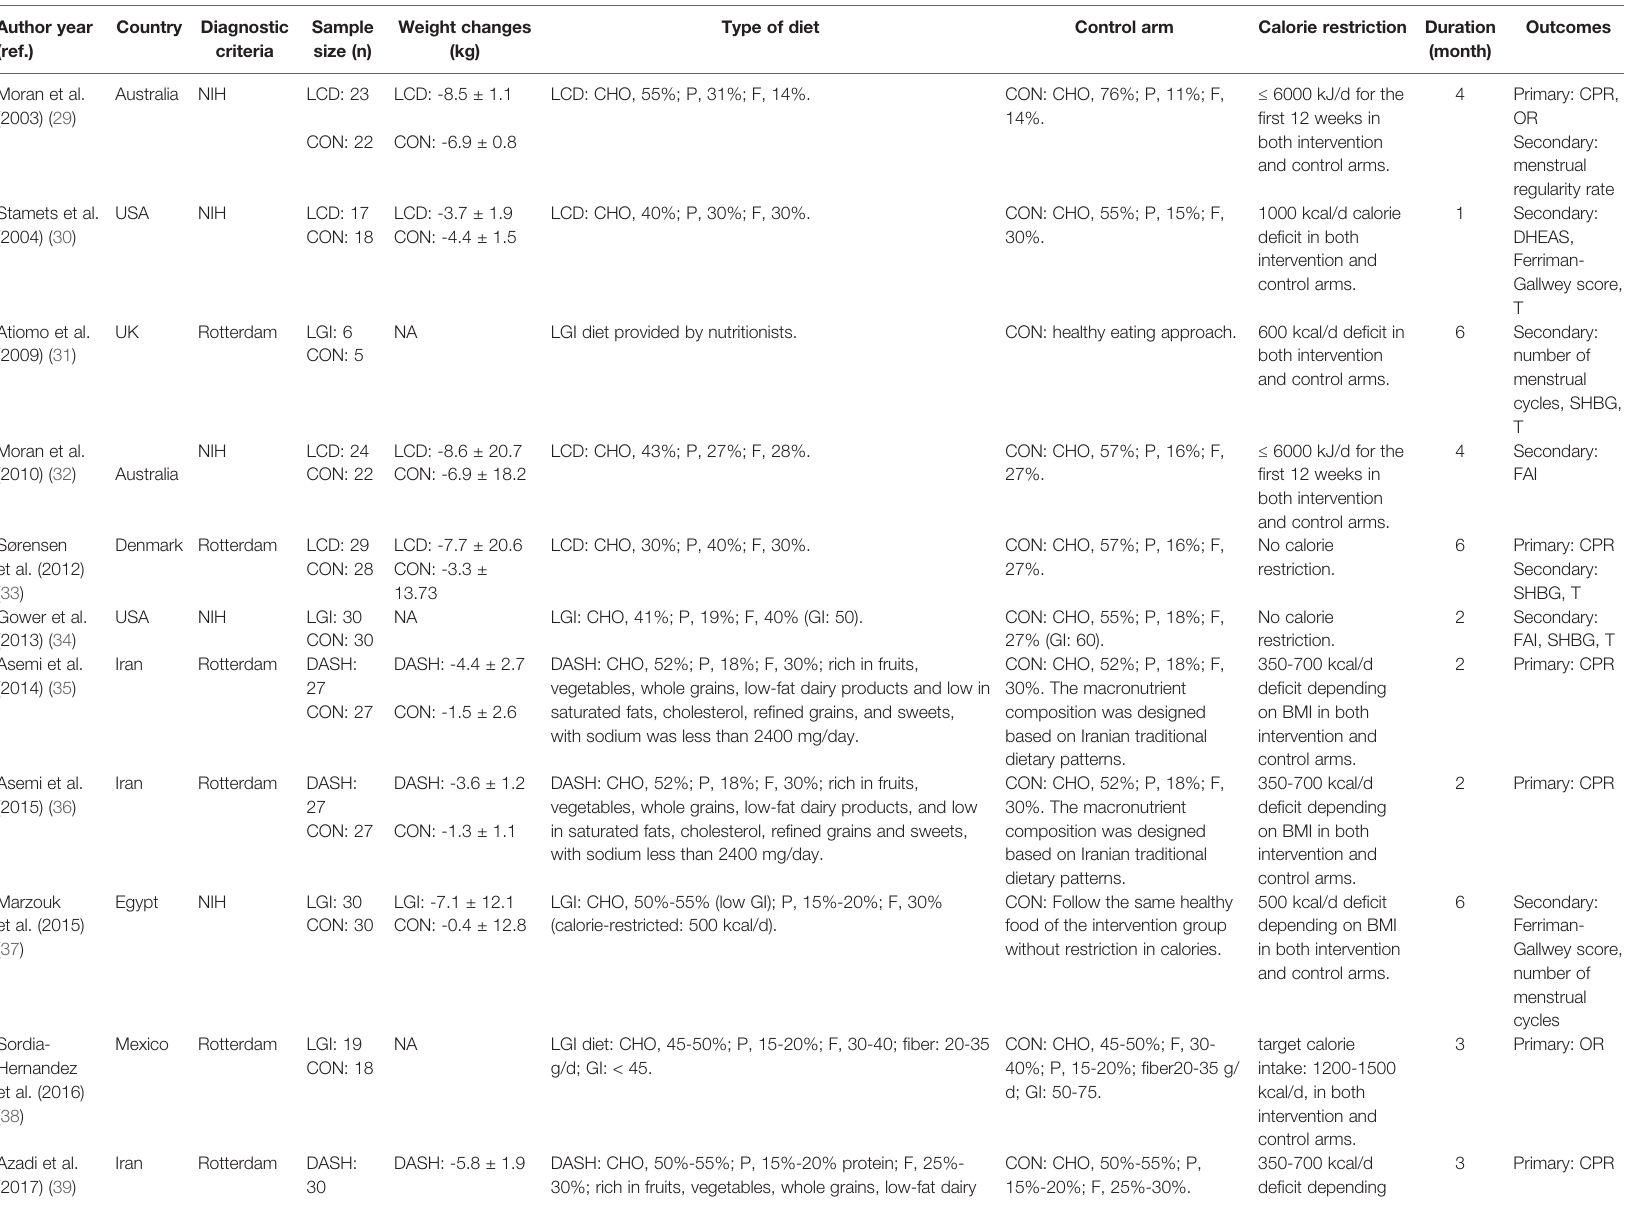
TABLE 1 | Characteristics of trials included in the meta-analysis. Author year